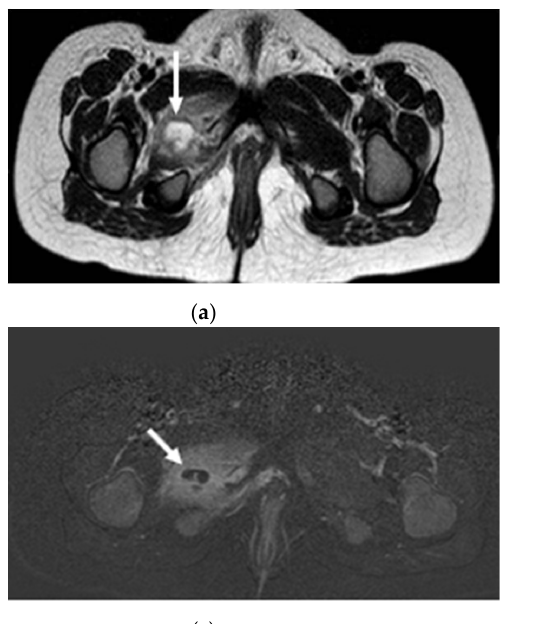
Figure 4. Pyomyositis of the obturator externus muscle in a 3-year-old child with a history of a fall from the bicycle. ( a ) Axial T2-weighted turbo spin echo (TSE) image shows the abscess (arrow) as an hyperintense fluid collection with hypointense wall. The abscess appears hyperintense (arrow) on ( b ) diffusion-weighted imaging (DWI) and hypointense with a thin hyperintense rim (arrow) on ( c ) axial post-contrast image. On T1-weighted images, the affected muscles appeared homogeneous ( n = 34) or heterogeneous ( n = 7) and they presented an isointense ( n = 25), hyperintense ( n = 15) or hypointense ( n = 1) signal compared to the surrounding healthy muscle. On T2-weighted images, the inflamed muscles showed homogeneous ( n = 19) or heterogeneous ( n = 18) signal (Figures 3c and 4a), hyperintense in all but one case ( n = 36), who presented isointense signal. Even the STIR sequences showed hyperintensity ( n = 39) or isointensity ( n = 6). All patients showed post-Gadolinium enhancement when MRI with contrast was performed ( n = 39) (Figures 3d and 4c). Abscesses appeared homogeneous ( n = 15) or